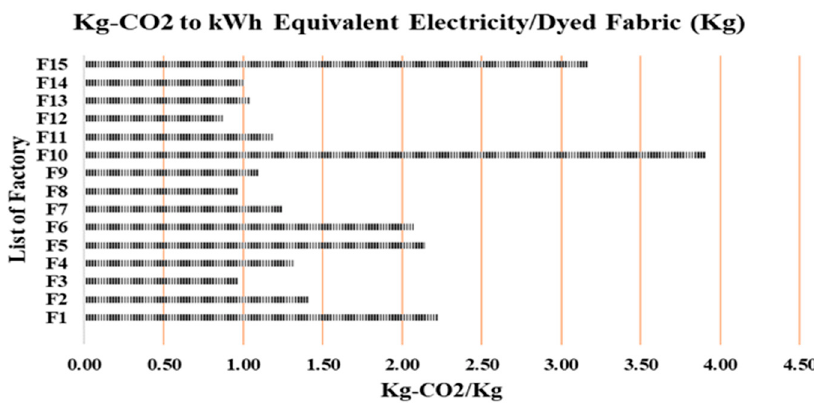
Figure 5. The ratio of energy consumption and dyed fabric (kWh/kg).